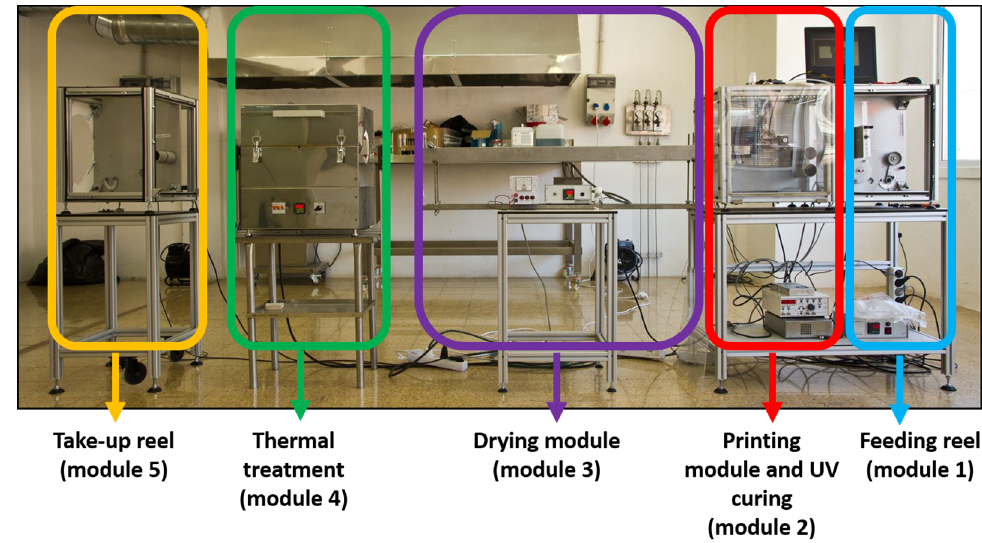
Figure 1. General photograph of the R2R continuous pre-pilot plant to deposit functional ceramic oxides by inkjet printing.